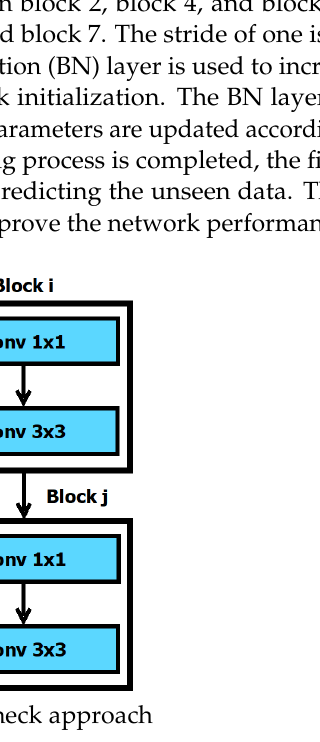
Figure 6. Analysis of Conv 1 × 1 vs. Conv 3 × 3.